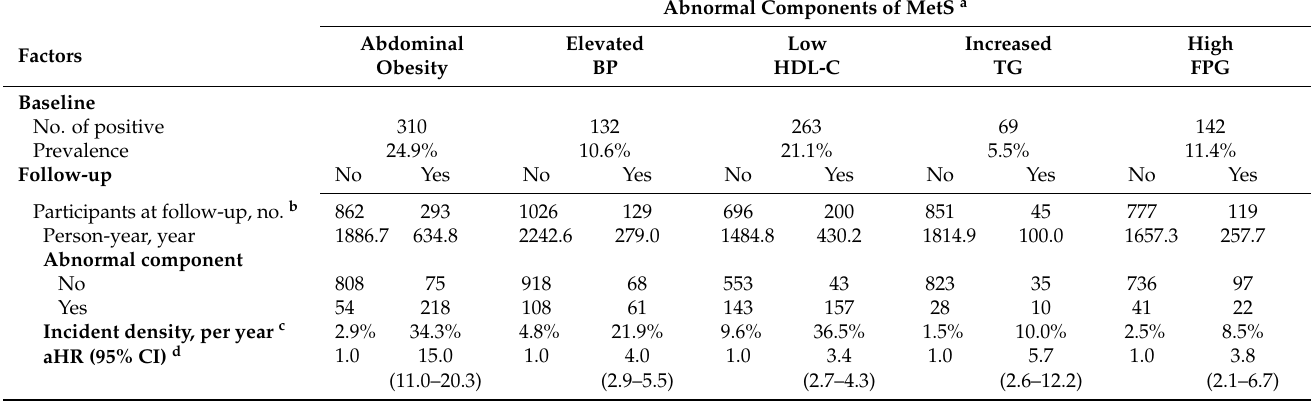
Table 6. Baseline prevalences, follow-up incidence densities, and adjusted hazard ratios of